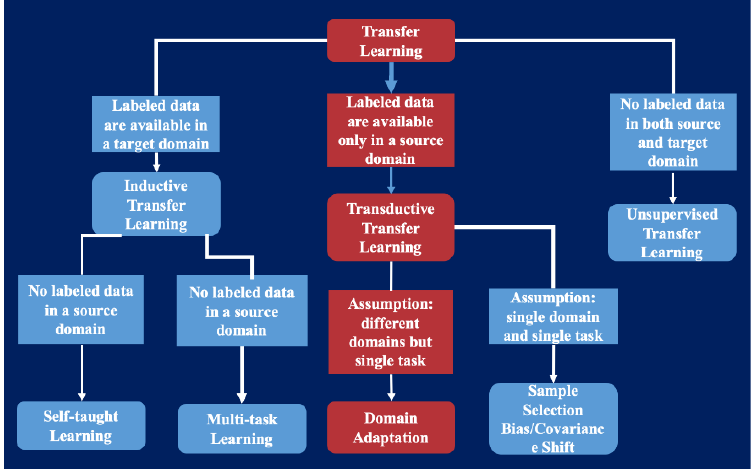
Figure 1. Relationship between transfer learning and domain adaptation.